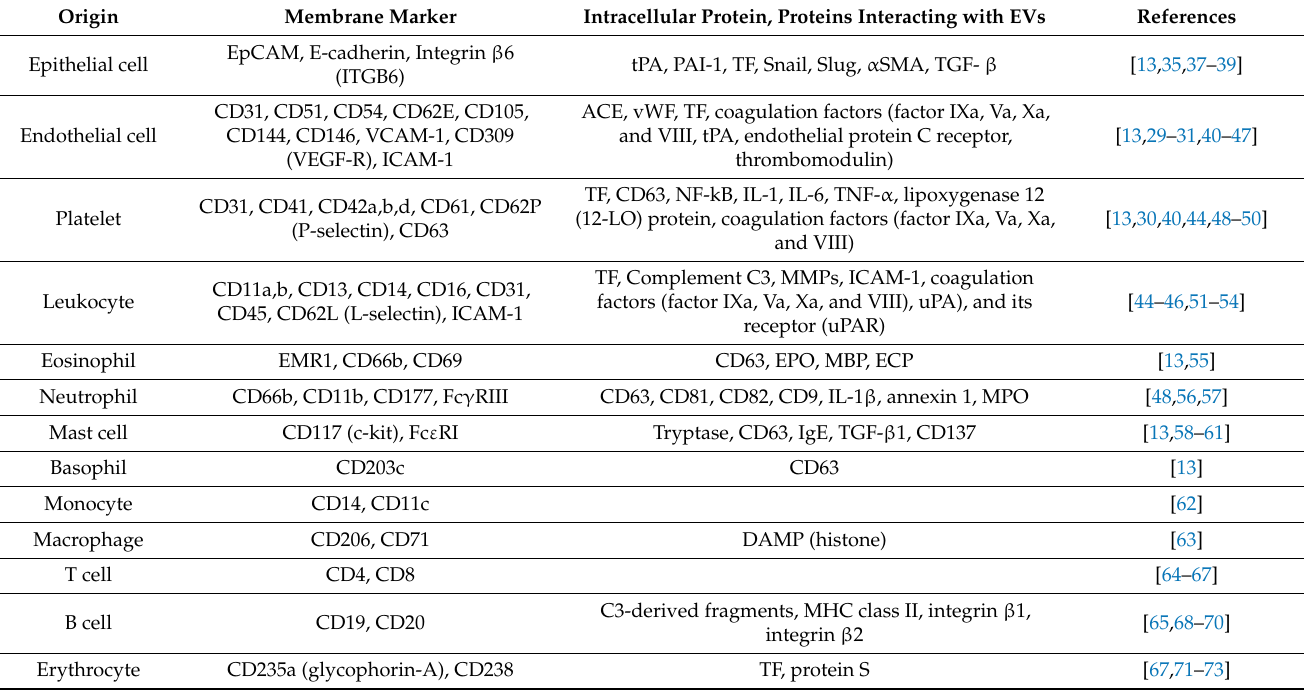
Figure 1. Schematic of MP release from activated and apoptotic cells. Adapted by permission from Elsevier. Ltd., Journal of Allergy and Clinical Immunology, Takahashi T, et al., copyright 5177010301838 [13]. Table 1. Membrane markers and intracellular proteins detected in EVs of various cell